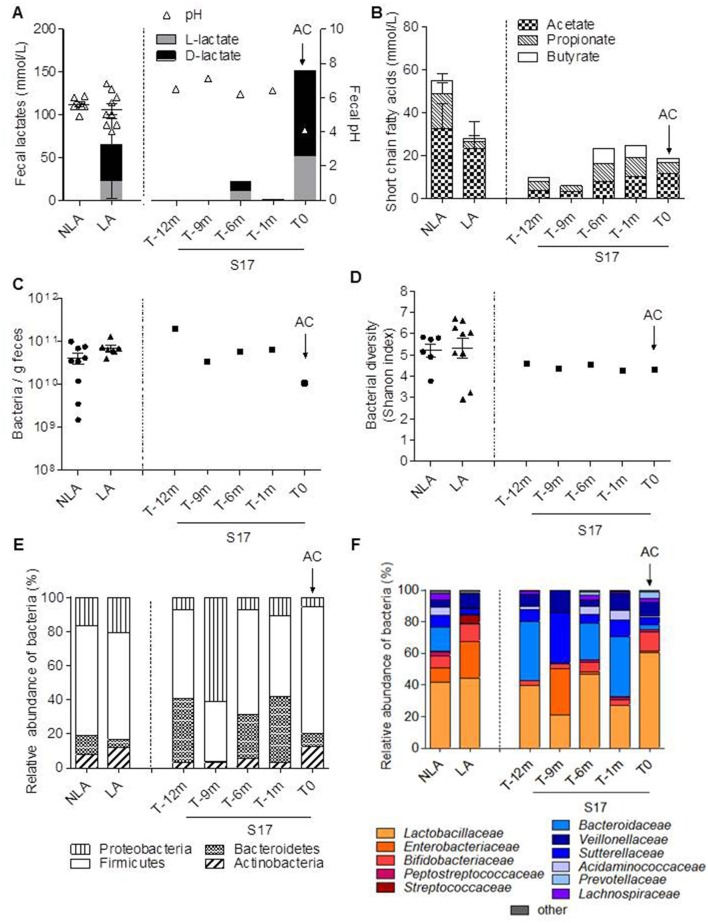
Fecal fermentative activity and microbial composition of 16 SBS patients clustered in NLA and LA sub-groups and patient S17. Sixteen patients, individually described in Mayeur et al. (2013), were clustered depending on the presence (LA) or absence (NLA) of lactates in their feces. One supplementary patient (S17) was followed during 1 year because it was known to be at risk for D-lactic acidosis. Samplings of S17 were performed 12 (T-12m), 9 (T-9m), 6 (T-6m), and 1 (T-1m) month before the acidosis crisis (AC at T0). (A) Fecal pH and the level of fecal D and L lactates (mmol/L), (B) the amount of fecal short chain fatty acids: acetate, propionate, butyrate (mmol/L), (C) fecal bacteria per gram, (D) fecal microbiota diversity (Shannon index), (E) distribution of principal bacterial phyla, (F) relative abundance of bacterial families in the feces. Lactate-producing bacteria are indicated in red and orange. Lactate-consuming bacteria are indicated by the different shades of blue.